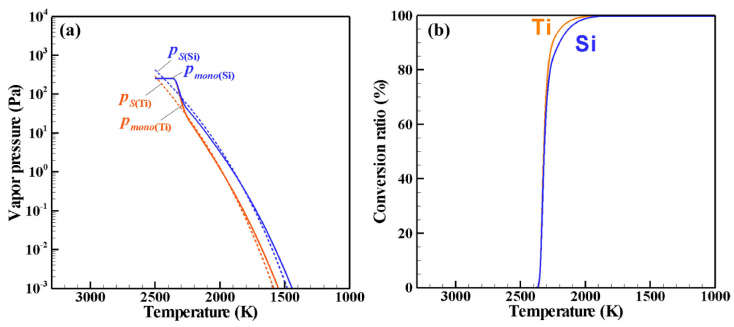
Figure 3. Phase conversion histories for ζ = 1: ( a ) vapor pressures and ( b ) conversion